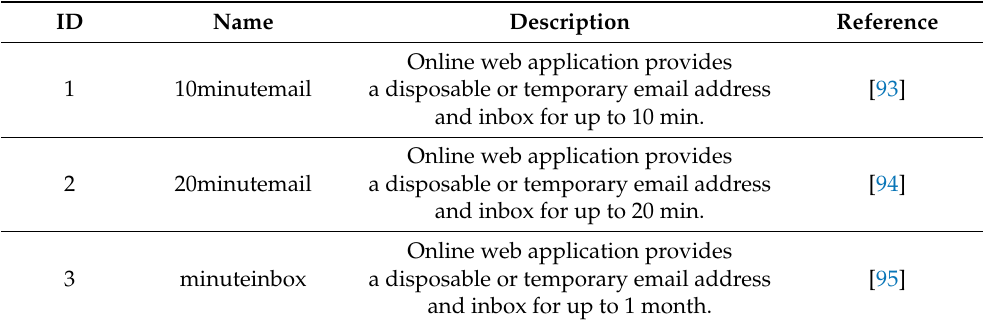
Table 22. Tools used for temporary email